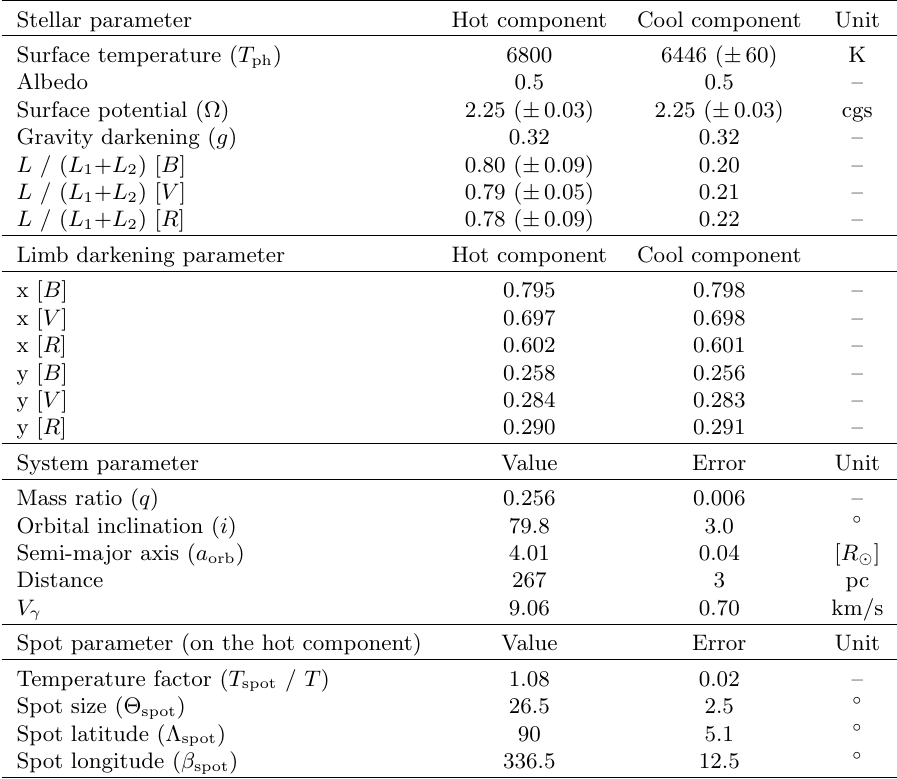
Table 4. Results of the simultaneous analysis of the light and radial velocity curves for V407 Peg.